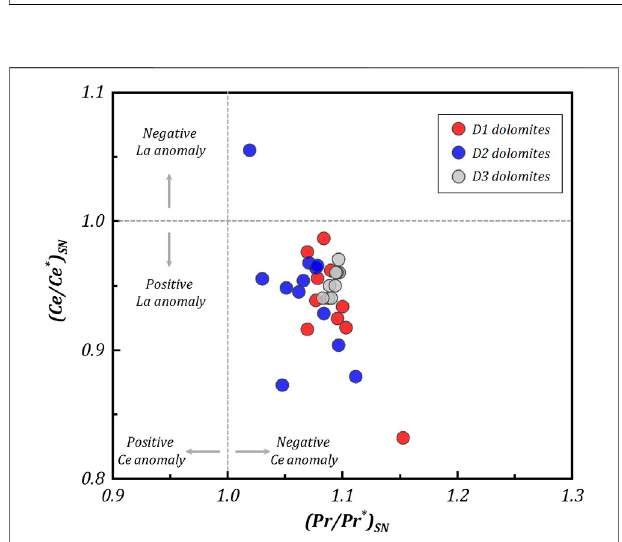
FIGURE 7 | Scatter diagram of (Pr/Pr*)SN with (Pr/Pr*)SN values of the investigated Middle – Upper Cambrian Xixiangchi dolomites.